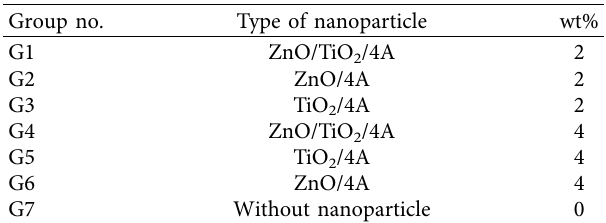
Table 1: Classification of test and control groups based on the type and percentage of nanoparticles added to the composition of SR Triplex ® cold powder. Group